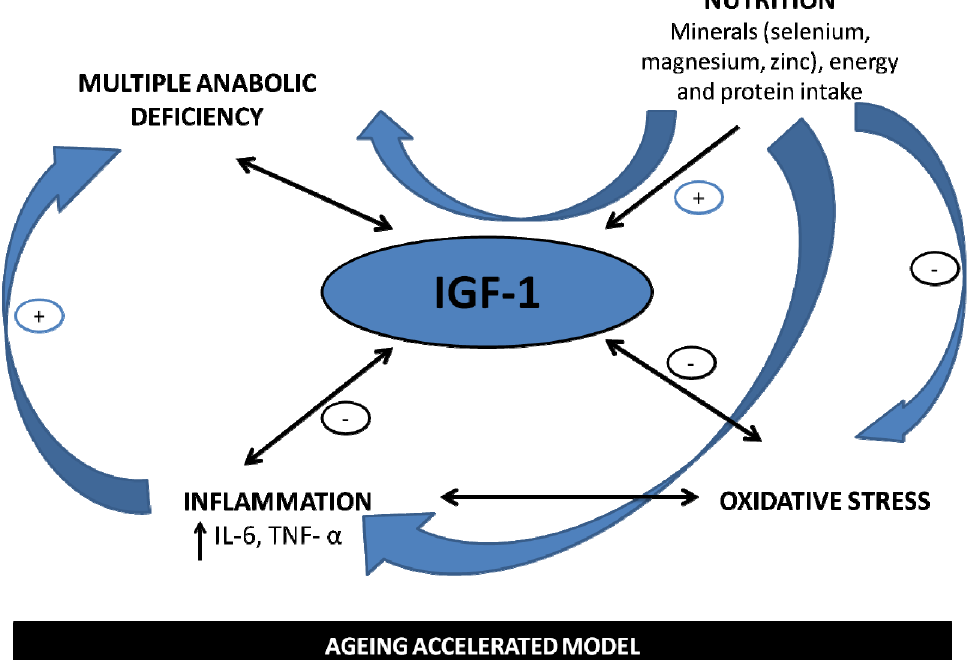
Figure 1. The central role of IGF-1 in the multiple pathways leading to increased frailty. IGF-1 is an ideal cross-road of hormonal anabolic milieu, nutritional and inflammatory statuses. IGF-1 levels are inversely related to inflammatory markers and oxidative stress and positively regulated by specific nutrients such as selenium, zinc, magnesium, along with energy and protein